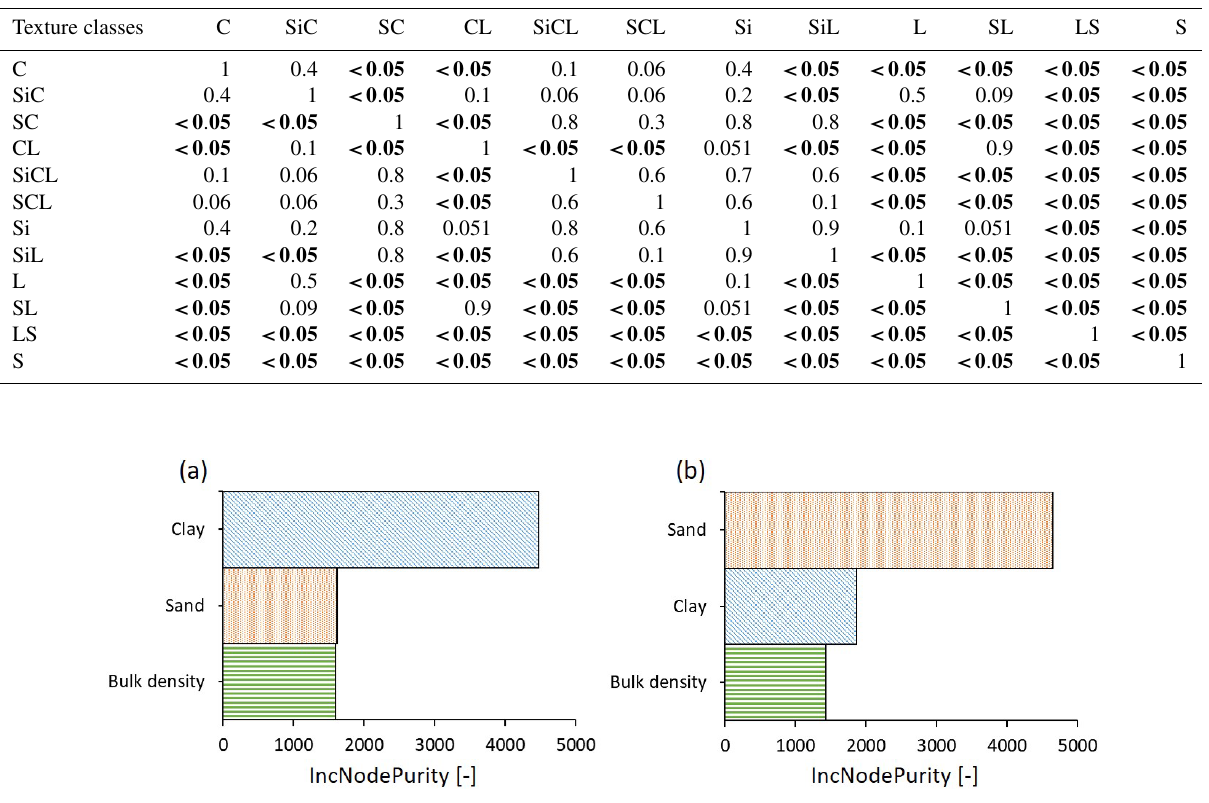
Figure A1. Importance of the variables for developing the PTFs for K sat using the random forest algorithm. The x axis displays the average increase in node purity (the larger the value, the more important a covariate). (a) Clay content was the most important variable followed by sand and bulk density for the random forest model built on data from temperate regions. (b) Sand content was the most important variable followed by clay and bulk density for the random forest model based on laboratory